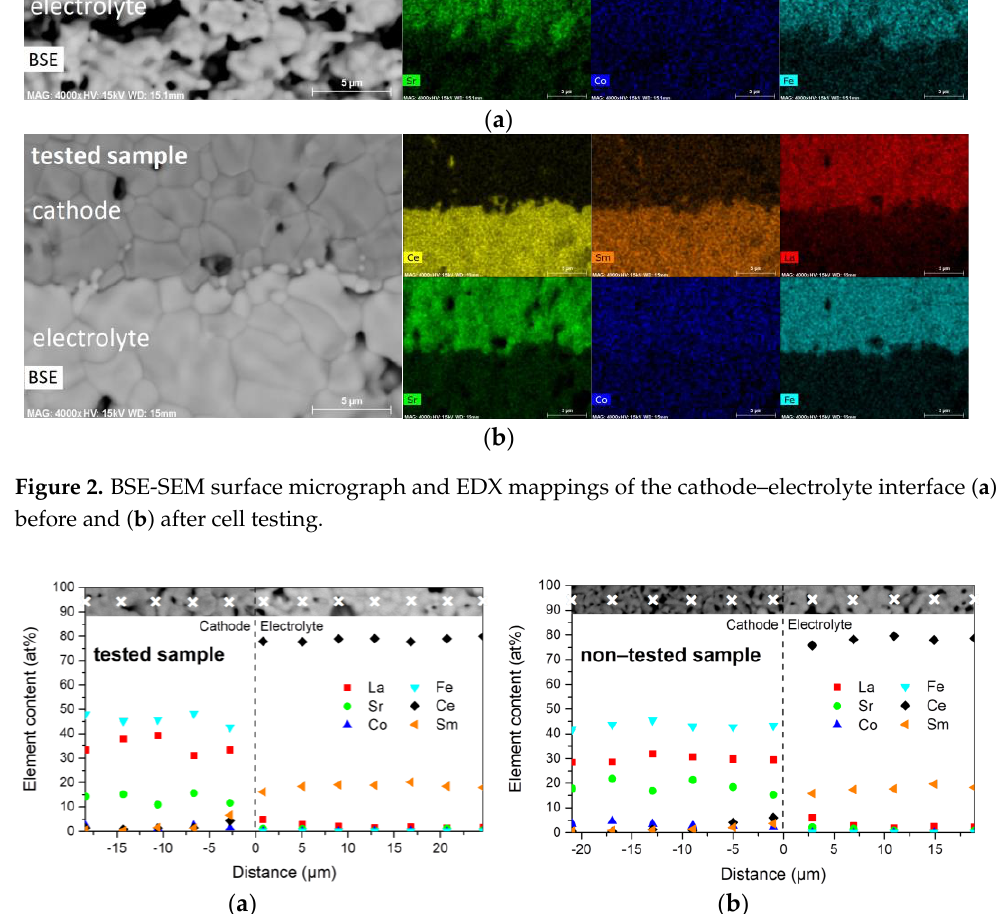
Figure 3. Elemental content evolution in the cathode and the electrolyte layers as a function of the distance from the interface, represented as a dashed line, for ( a ) the tested sample and ( b ) the non- tested sample. EDX point measurements were acquired at each cross on the SEM-BSE micrograph inserted at the top of the figures.